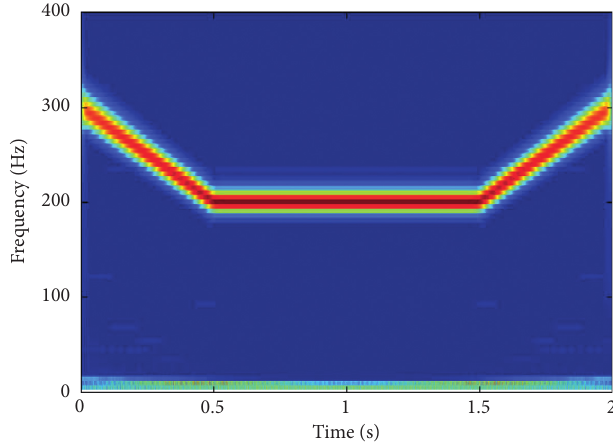
Figure 5: Wavelet transform of the excitation.